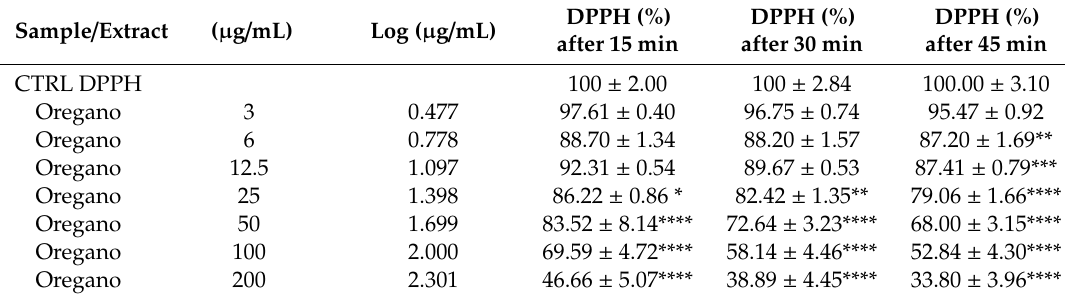
Table 4. Antioxidant activity of different doses of Origanum vulgare EO. Data are reported as mean ± SD of three replicates. DPPH: 2.2-diphenyl-1-picrylhydrazil.